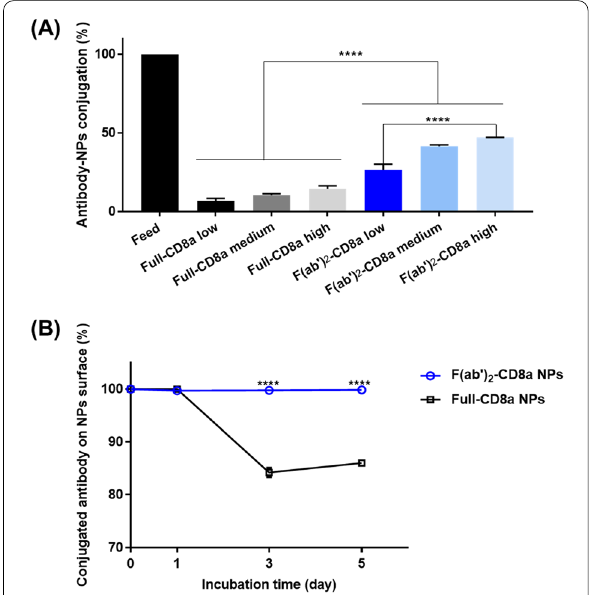
Fig. 2 Conjugation efficiency and stability of the antibodies to the surface of NPs. A Conjugation efficiency of each NPs compared with added antibody. Data were presented as the mean (n 3, ****P < 0.0001). B The binding stability of the antibodies = conjugated to the NPs is determined by the change in the number of antibodies bound to the NP surface over the incubation period (25 ℃ , shaking condition). Data were presented as the mean **** P <